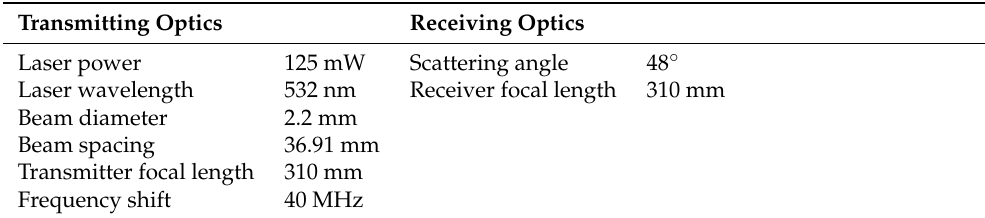
Table 1. Optical configuration of the Dantec Dynamics PDA system for the droplet size and velocity